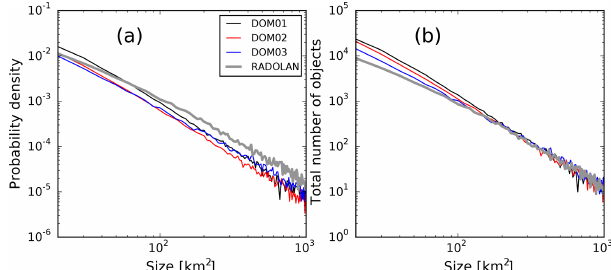
Figure 3. (a) Normalized probability density function (PDF) of rain cell size distributions, on all three domains DOM01, DOM02, and DOM03 and the RADOLAN data. (b) Same as (a) , but with total number of cells on the vertical axis (in bins of width 10km 2 ). The PDF includes all rain cells between 06:00 and 21:00UTC on all 3d (29 May, 3 June, 6